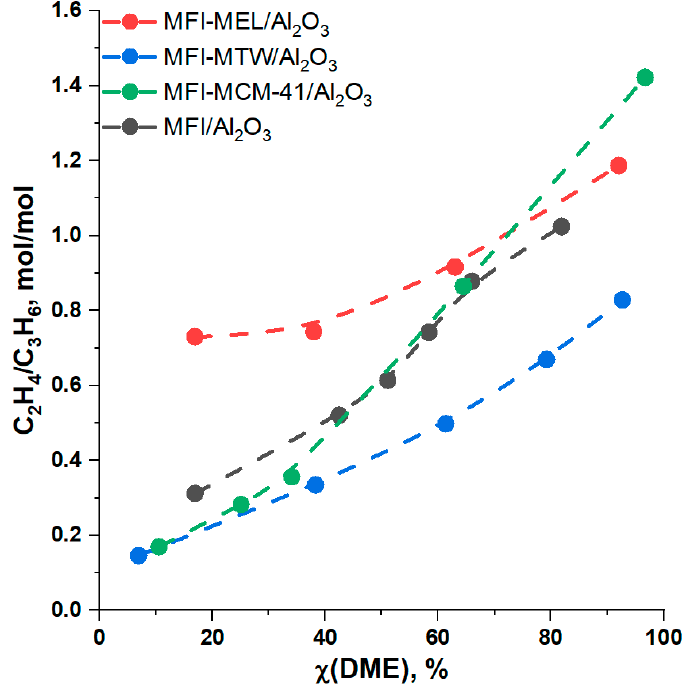
Figure 5. Ethylene/Propylene mole ratio as a function of DME conversion. p = 1 atm, T = 340 °C.